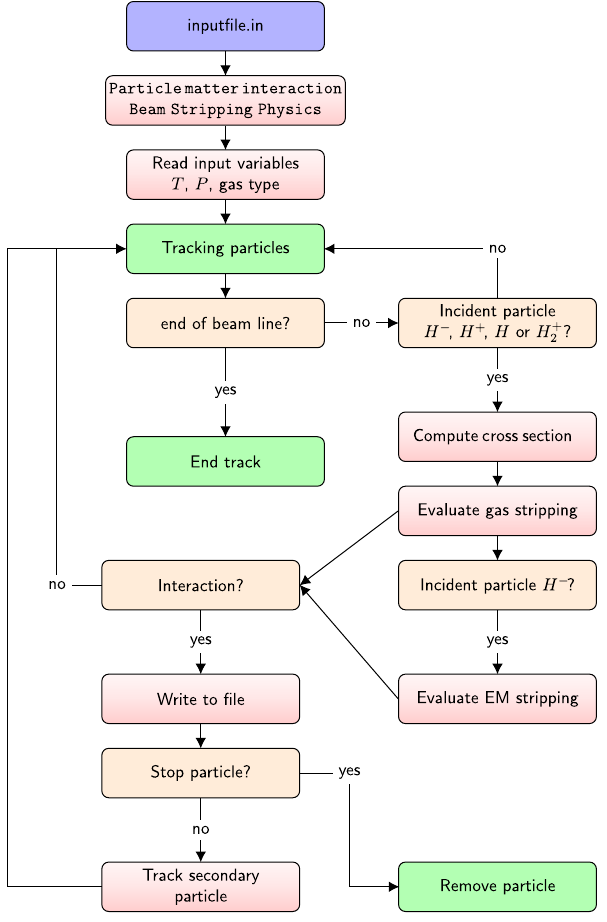
FIG. 1. OPAL beam stripping physics algorithm